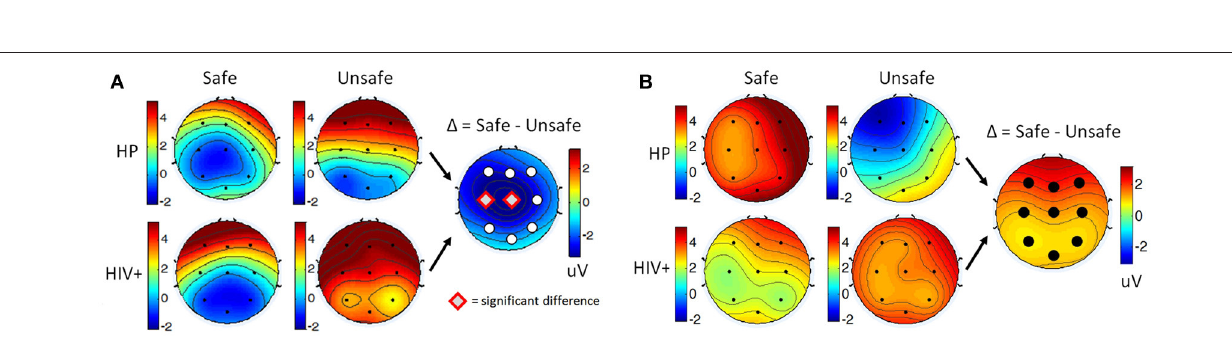
FIGURE 6 | Grand Average ERP plots (averaged across participants) for (A) Non-Target and (B) Target trials during 3CVT task plotted for Safe (blue)/Unsafe (red).